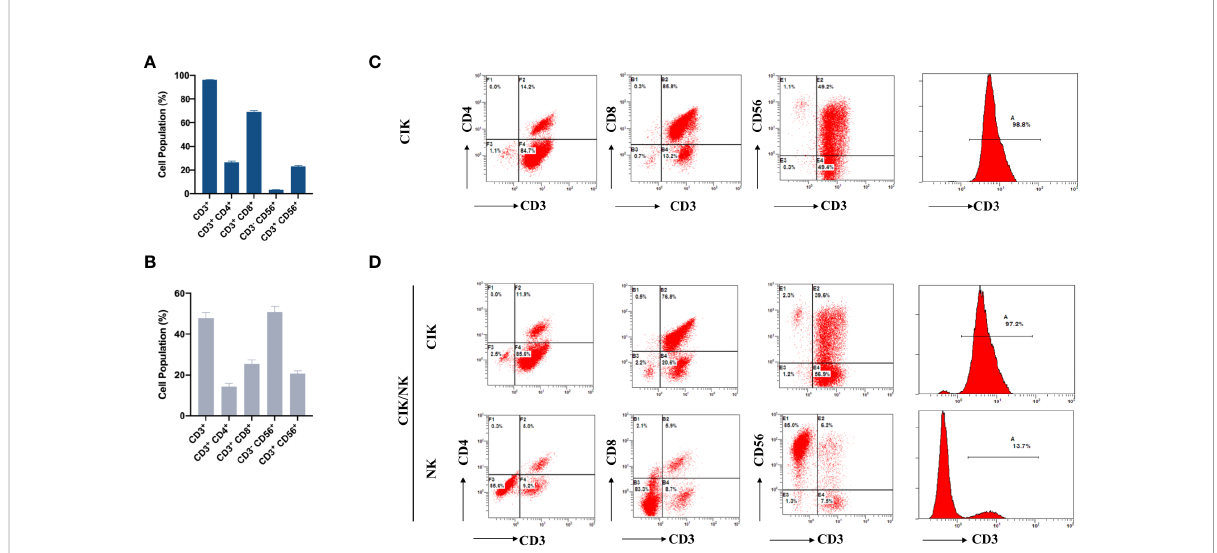
FIGURE 2 Phenotypic analysis of CIK cells and NK cells in breast cancer patients after the fi rst expansion. (A) The phenotype of autologous CIK cells from 65 patients in each cycle was evaluated using fl ow cytometry. The percentage of CD3 + , CD3 + CD4 + , CD3 + CD8 + , CD3-CD56 + and CD3 + CD56 + are shown. (B) The phenotype of autologous NK cells from 24 patients in each cycle was evaluated using fl ow cytometry. The percentage of CD3 + , CD3 + CD4 + , CD3 + CD8 + , CD3-CD56 + and CD3 + CD56 + are shown. (C) Typical fl ow cytometry analysis of CD3 + CD4 + T cells, CD3 + CD8 + T cells, CD3 + CD56 + NKT cells, and CD3 − CD56 + NK cells after expansion in CIK group. (D) Typical fl ow cytometry analysis was performed on two different types of expanded cells from CIK/NK patients. The data were collected from the same patient. The results were from 89 CIT patients and are represented as mean ±